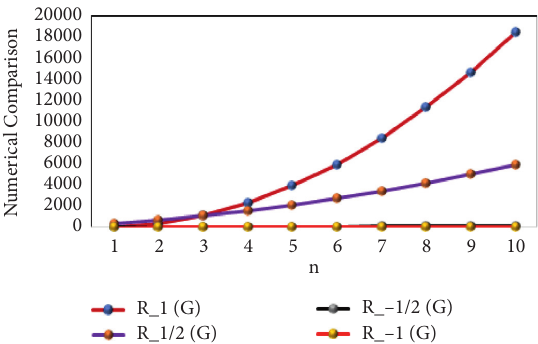
Figure 5: Two-dimensional numerical comparison of Star of David